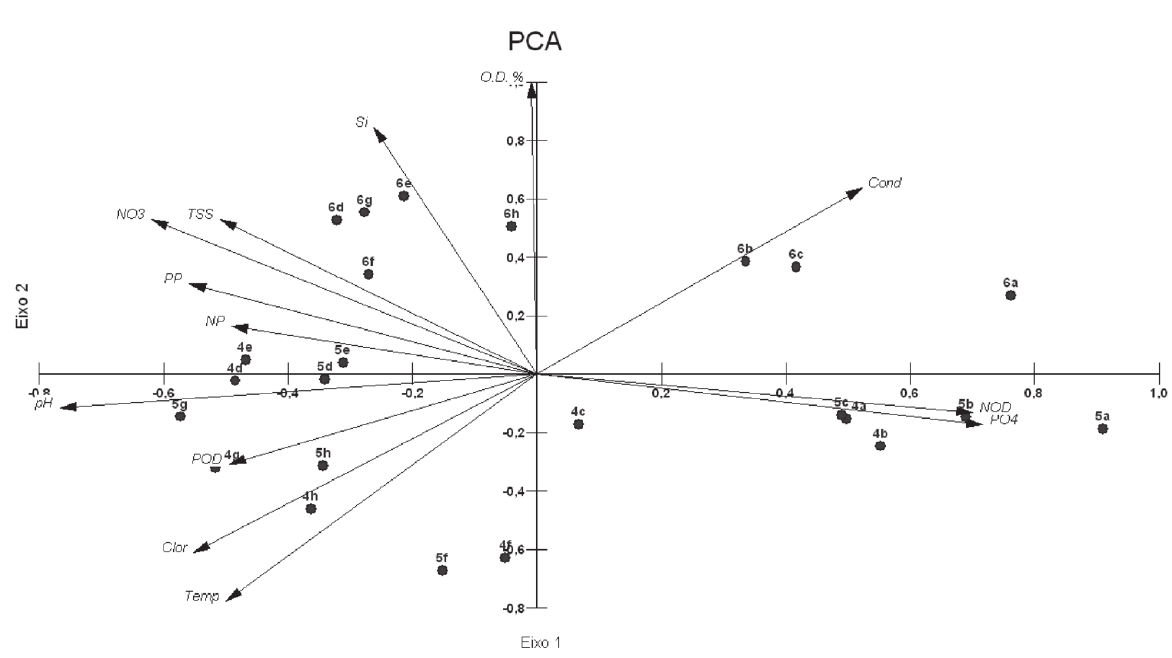
Figure 9 - Principal Component Analysis for the physical-chemical data, TSS, Chlorophyll, Nitrogen (PN, nitrate and DON), phosphorus (PP, phosphate and DOP) and silicate. The numbers 4, 5 and 6 represent the campaigns 4, 5 and 6 representative of wet, intermediate and dry periods respectively, and the letters from (a) to (h) represent the stations from 1 to